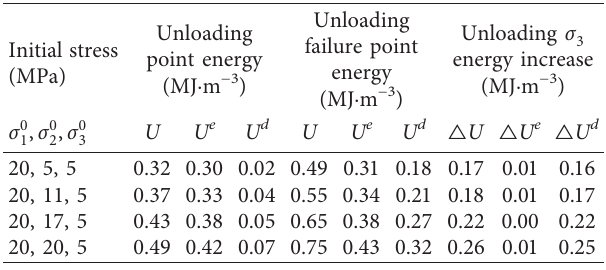
Table 3: The energy of unloading and failure points under different σ . 2